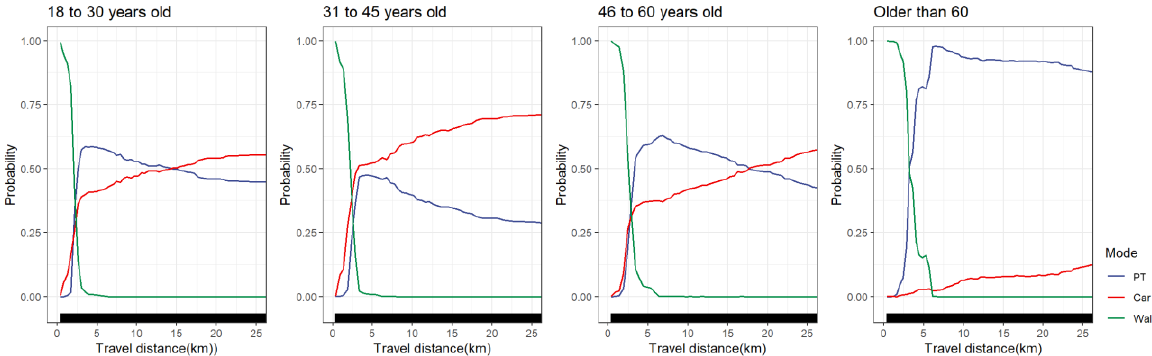
Figure 10. PDP plot of age groups